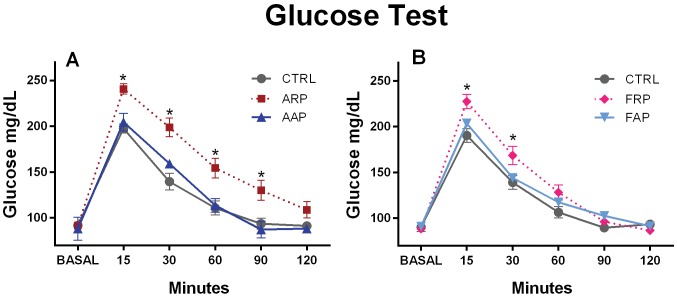
Glucose intolerance after 4 weeks of activity and or food in the rest phase.Animals received at time 0 (basal) an intraperitoneal injection of 1 g of glucose per kg body weight. Glucose levels in ARP animals show immediately after the glucose injection an increase in plasma glucose levels that remained significant higher as compared to the AAP and CTRL group until 90 minutes after the challenge. Glucose levels in FRP animals show after the glucose injection a similar increase in plasma glucose levels; however at 60 minutes no difference between FAP and CTRL group can be noted.